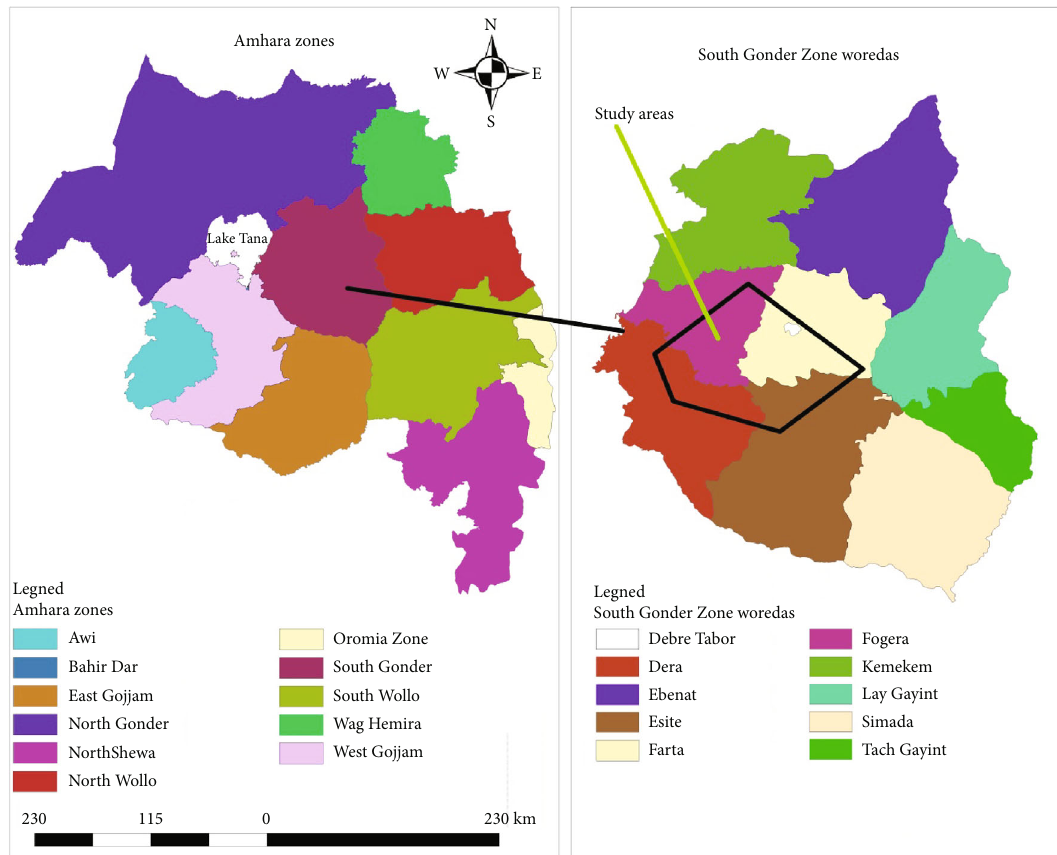
Figure 1: The map of the Amhara Region and the study area